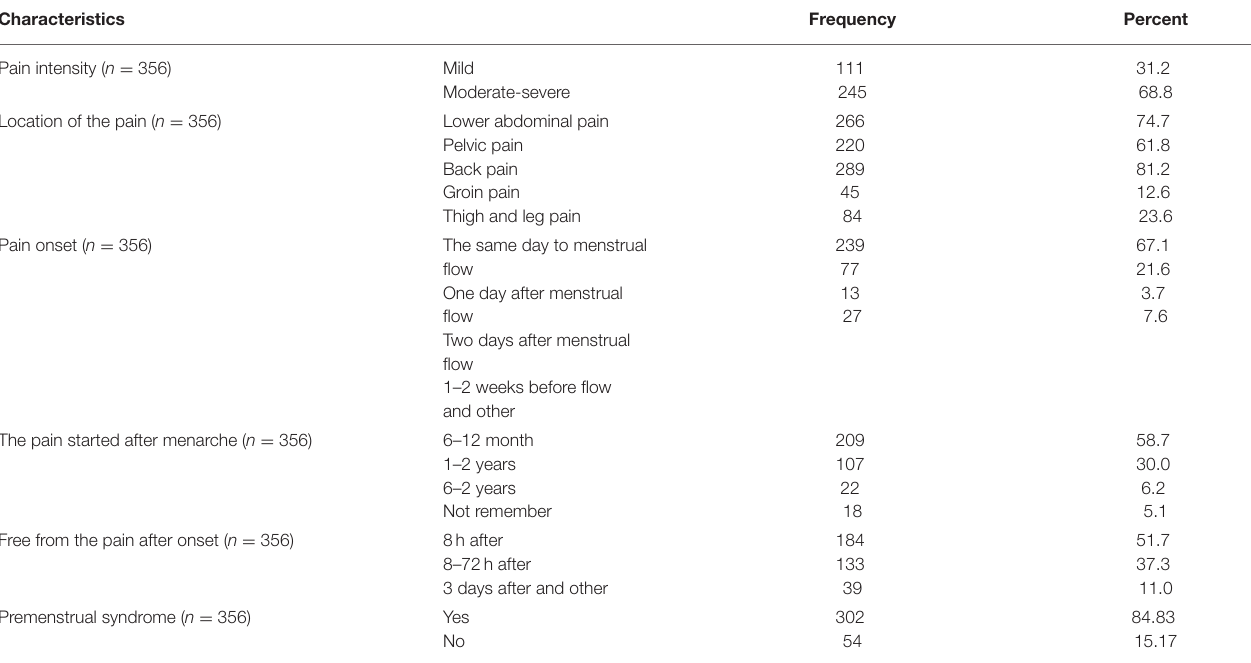
TABLE 3 | Dysmenorrhea pain intensity of female undergraduate students, at Haramaya University, Ethiopia, 2020.